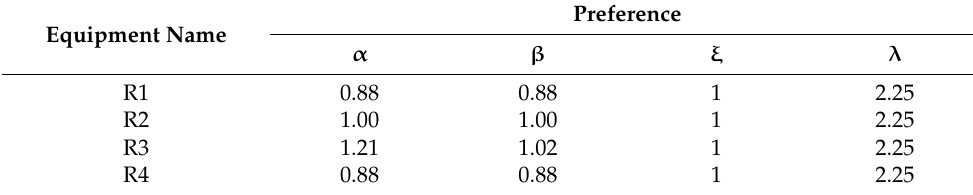
Table 5. Attributes of the red side’s C2